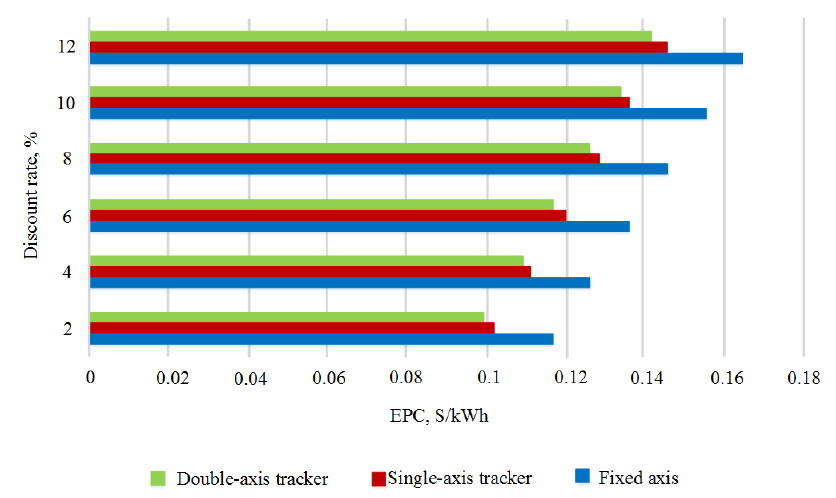
Fig. 8. Sensitivity analysis of discount rate on NPV.